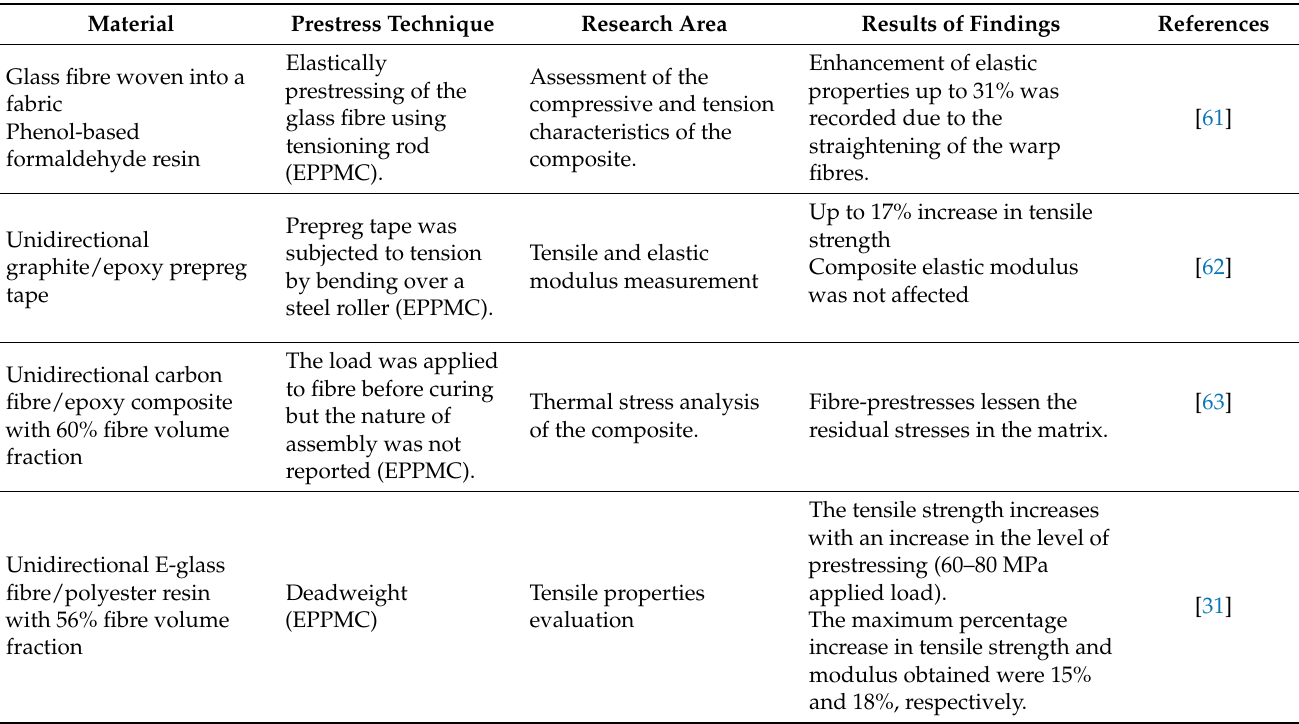
Table 2. Reviews on fibre-prestressed PMC.